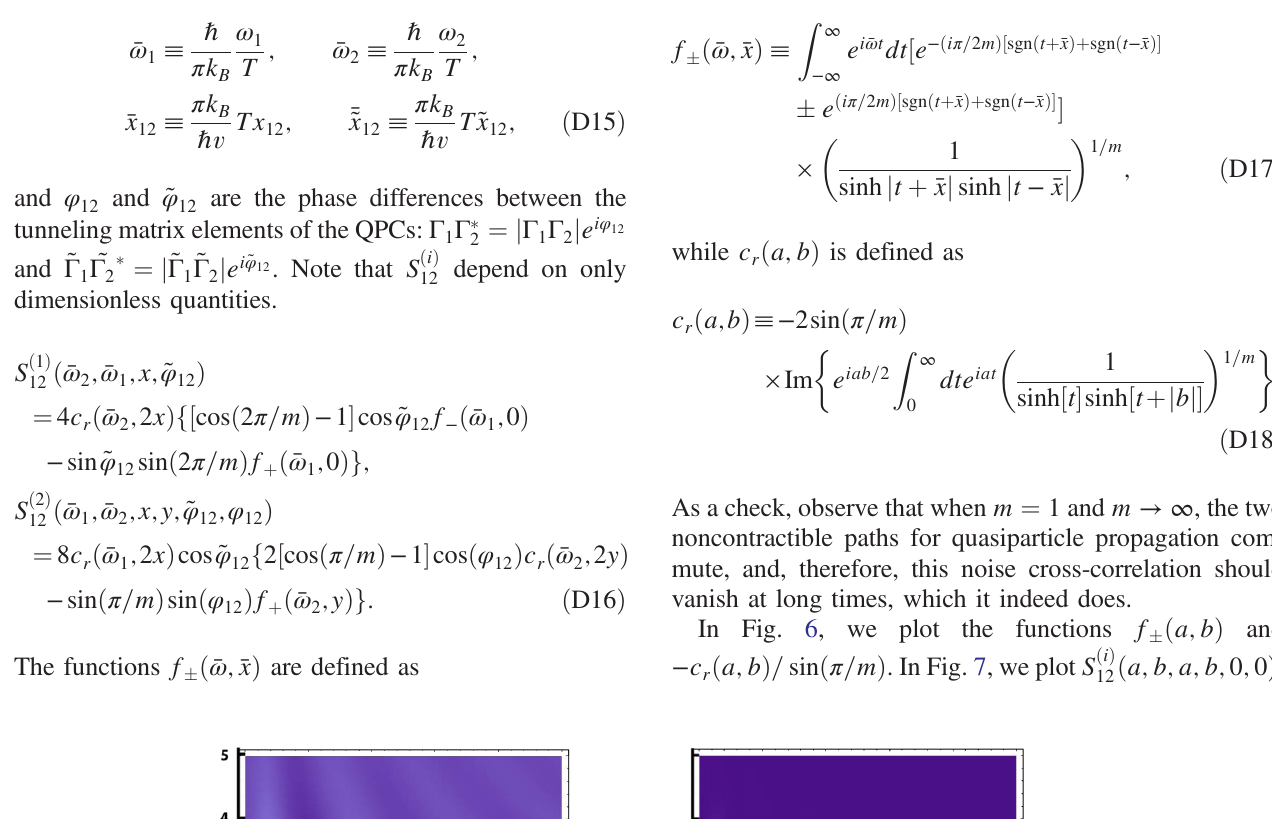
ð a; b Þ , for m ¼ 3 . þ